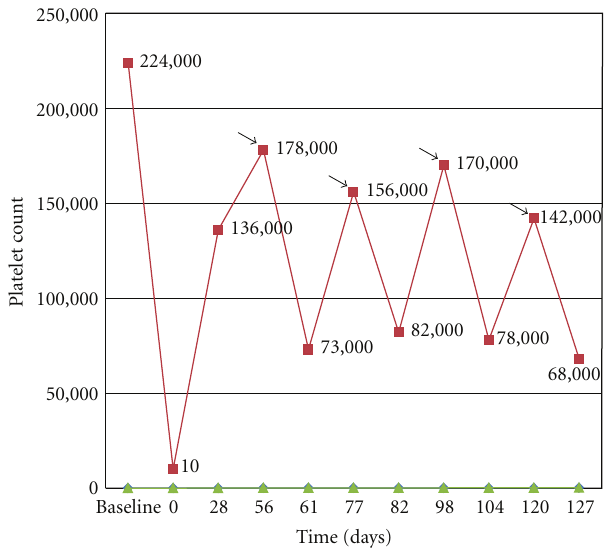
Figure 1: Changes in platelet count in relation to treatment with Bevacizumab. Arrows indicate injection of bevacizumab